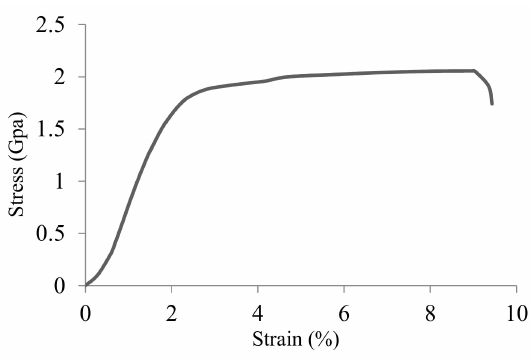
Figure 4. Stress–strain curve of the specimen obtained from a tensile test.